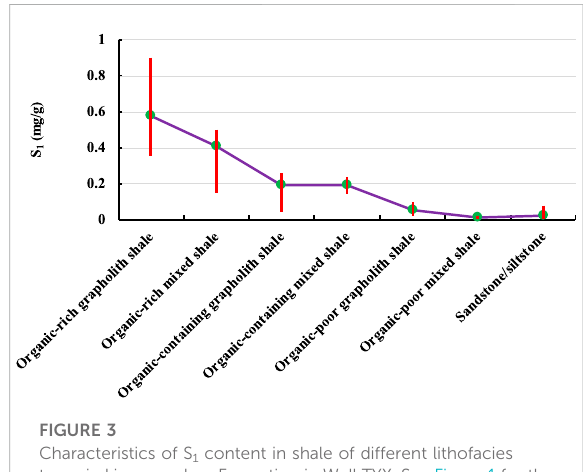
FIGURE 3 Characteristics of S 1 content in shale of different lithofacies types in Lianggaoshan Formation in Well TYX. See Figure 1 for the well